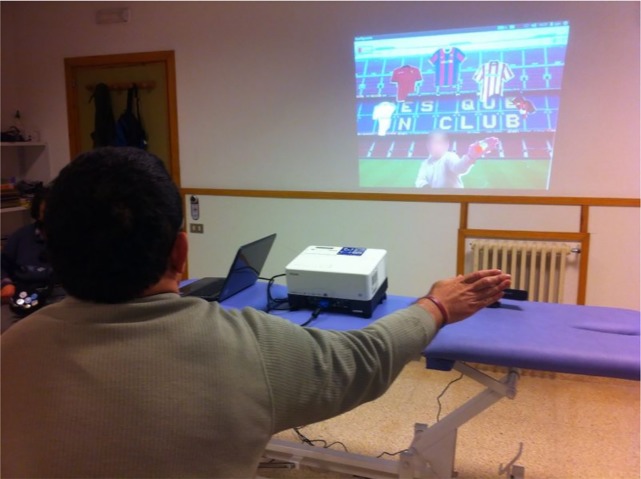
Therapy session.